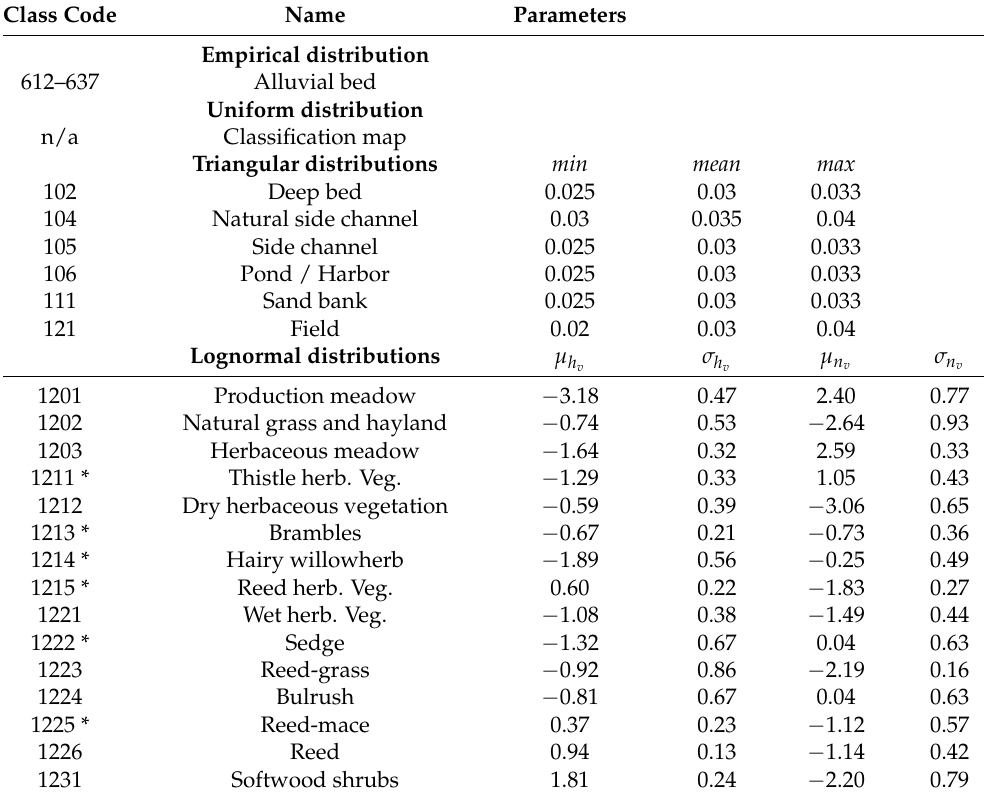
Table A1. Parameters of the floodplain roughness class distributions. Codes marked with an asterisk * are not used in the Waal